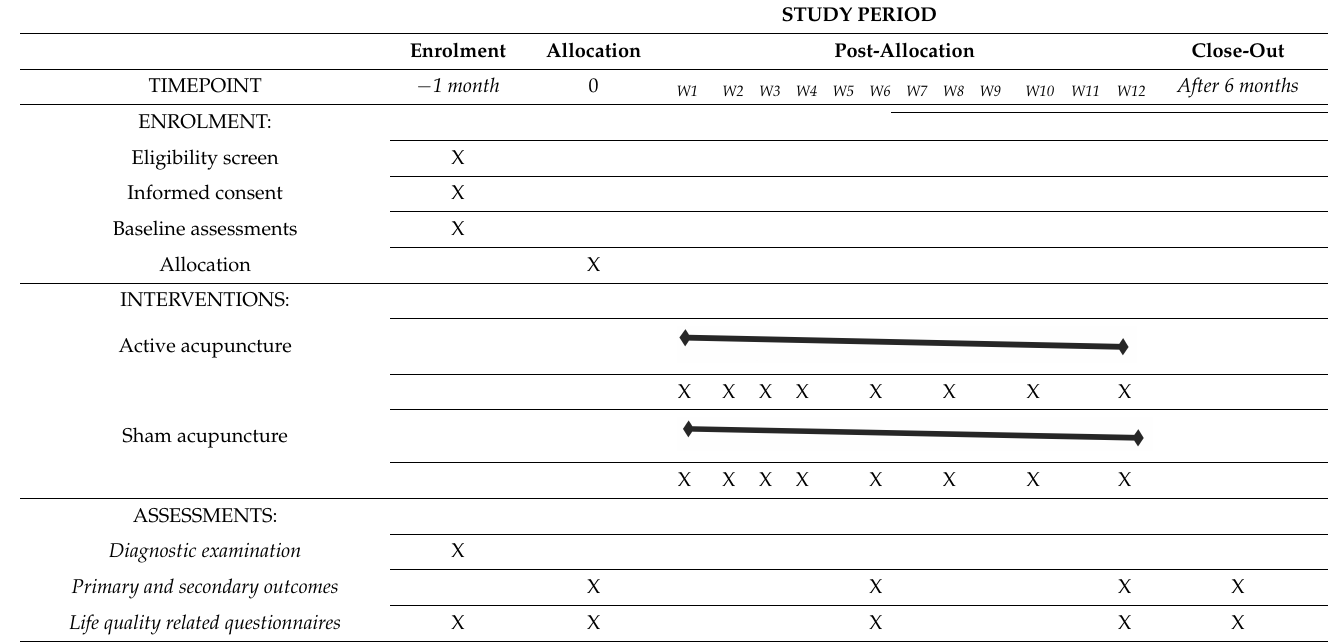
Table 2. SPIRIT schedule of enrolment, interventions, and